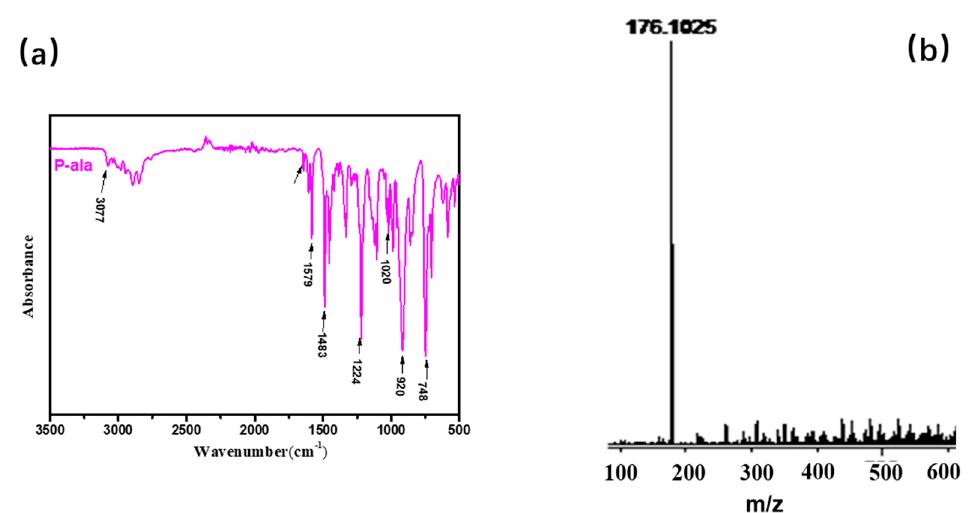
Figure 2. 1 H NMR spectra of BOZ.